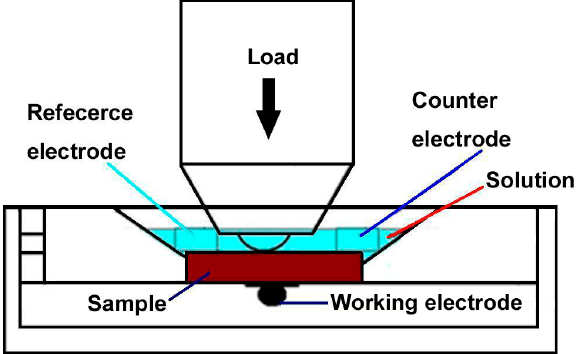
Figure 1. Scheme of the tribocorrosion apparatus.